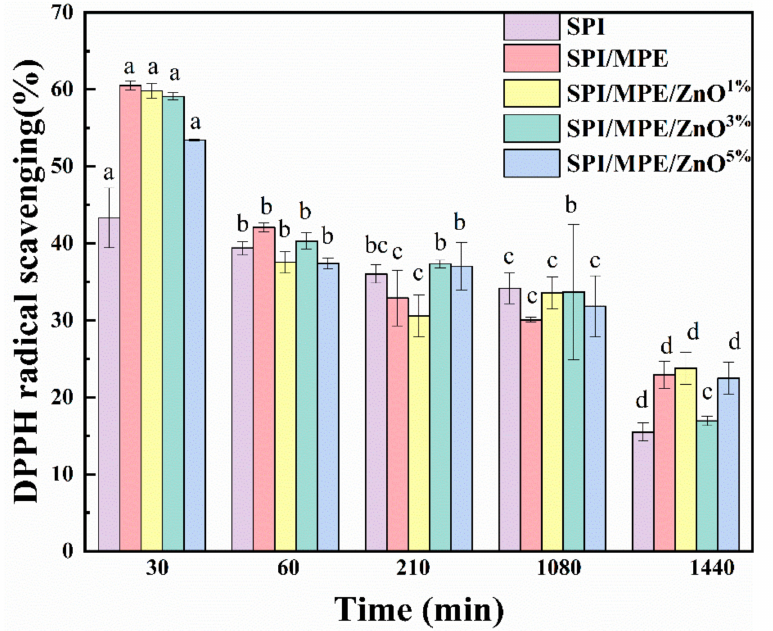
Figure 3. DPPH radical scavenging ability of the SPI films. All data are shown as mean ± standard deviation (SD). The superscripts different letters in a column indicate significant differences ( p ≤ 0.05). The antimicrobial activity of SPI films against E. coli and S. aureus are shown in Table 2 and Figure S3. As expected, the SPI film did not reveal antibacterial activity. However, the SPI film incorporated with MPE showed strong antibacterial efficacy against both E. coli and S. aureus ( p ≤ 0.05). The antimicrobial activity of SPI/MPE film was attributed to the effect of phenolic compounds in MPE, which inhibited bacterial growth by disrupting the stability of the cell plasma membrane and the permeability of the cell membrane [40]. With the addition of ZnO NPs, the SPI/MPE/ZnO film showed the strongest antibacterial activity, which may be related to the combined effect of MPE and ZnO NPs [40]. The composite films containing 3% and 5% ZnO NPs showed the highest antibacterial activity against E. coli (100%) and S. aureus (97%) after 1 h, respectively. A possible mechanism for the bacterial inhibitory activity of ZnO NPs is the generation of highly reactive oxygen species (ROS) on zinc oxide surface [9]. The negatively charged superoxide and hydroxyl radicals can stay inside the bacteria’s outer cell wall, damaging proteins, lipids, and DNA, while hydrogen peroxide can penetrate the cell wall and cause cell death [9]. Compared with SPI films incorporated with ZnO NPs, the antibacterial activities arrived at the same level in the case of the different solid content of ZnO NPs (Table